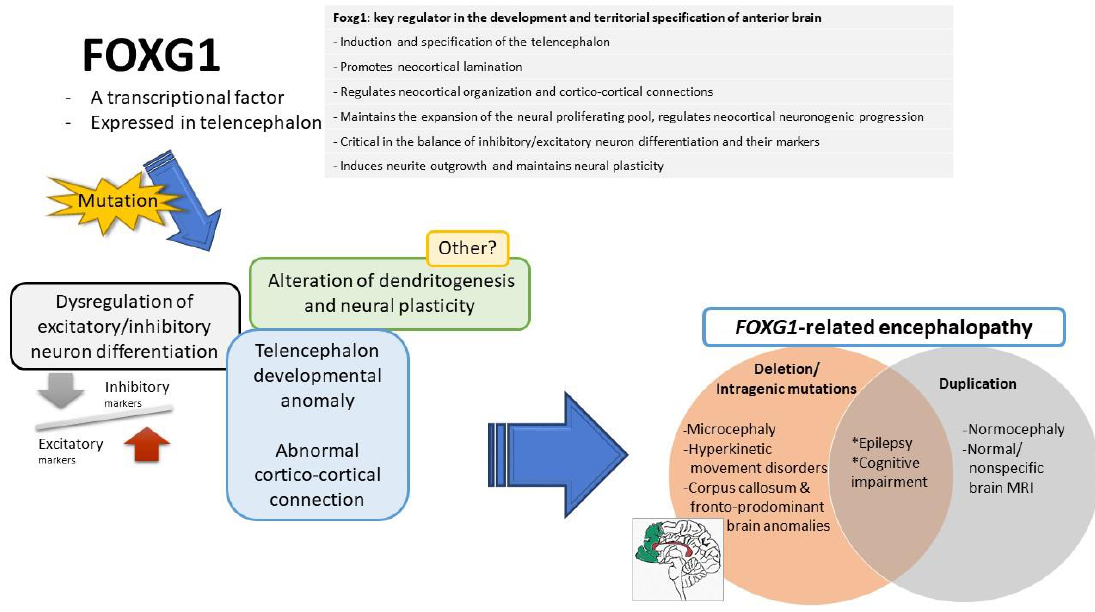
Figure 4. The possible functions of FOXG1 (right upper), which have been demonstrated in in vivo animal models: The mutations of FOXG1 gene may lead to possible pathological events (left), including dysregulation of excitatory / inhibitory neuron di ff erentiation, telencephalon developmental anomaly, abnormal cortico-cortical connection, and alteration in dendritogenesis and neural plasticity. These may be the underlying possible pathomechanisms leading to FOXG1 -related encephalopathy (right lower). In addition, it maintains the expansion of the neural proliferating pool [87], properly tunes the neuronal di ff erentiation rate, and regulates the pace of neocortical neurogenic progression. Constitutive suppression of FOXG1 in cortical progenitor cells leads to their di ff erentiation as Cajal–Retzius cells, the earliest-born neuron in the developing cerebral cortex [86]. FOXG1 is dynamically expressed in later-born neurons (transient downregulation and later re-expression), to coordinate their progression through the multipolar pyramidal precursor, and subsequent migration toward the cortical plate [88], as well as the proper timing of upper-layer and lower-layer neurogenesis [89]. In